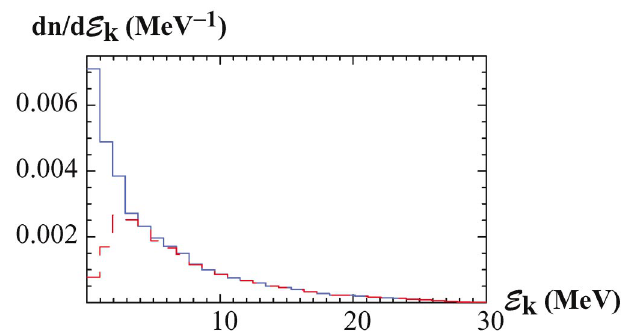
8. (Color) For emission uniform with (cid:17) : distribution in kinetic energy of dark current exiting the structure (solid) and entering the detectors (dashes), at the downstream . cell